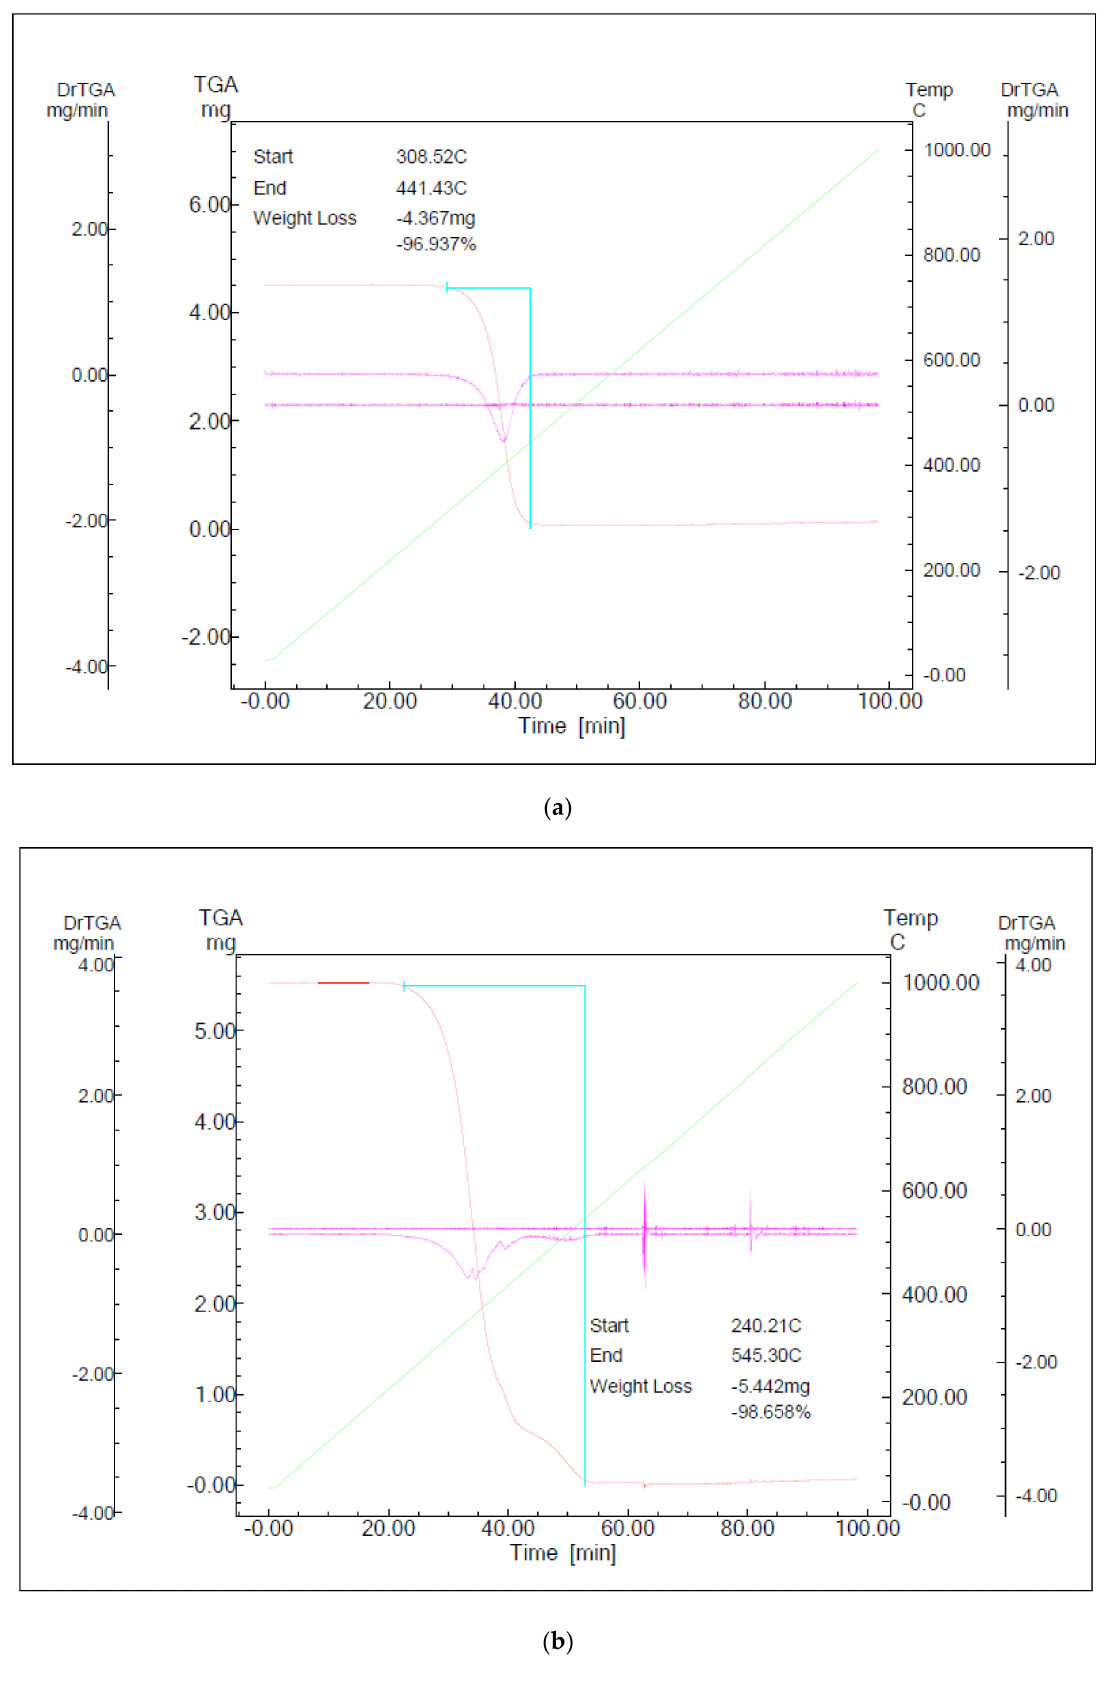
Figure A14. TGA Sample AA-100M ( a ) Nitrogen atmosphere ( b ) air